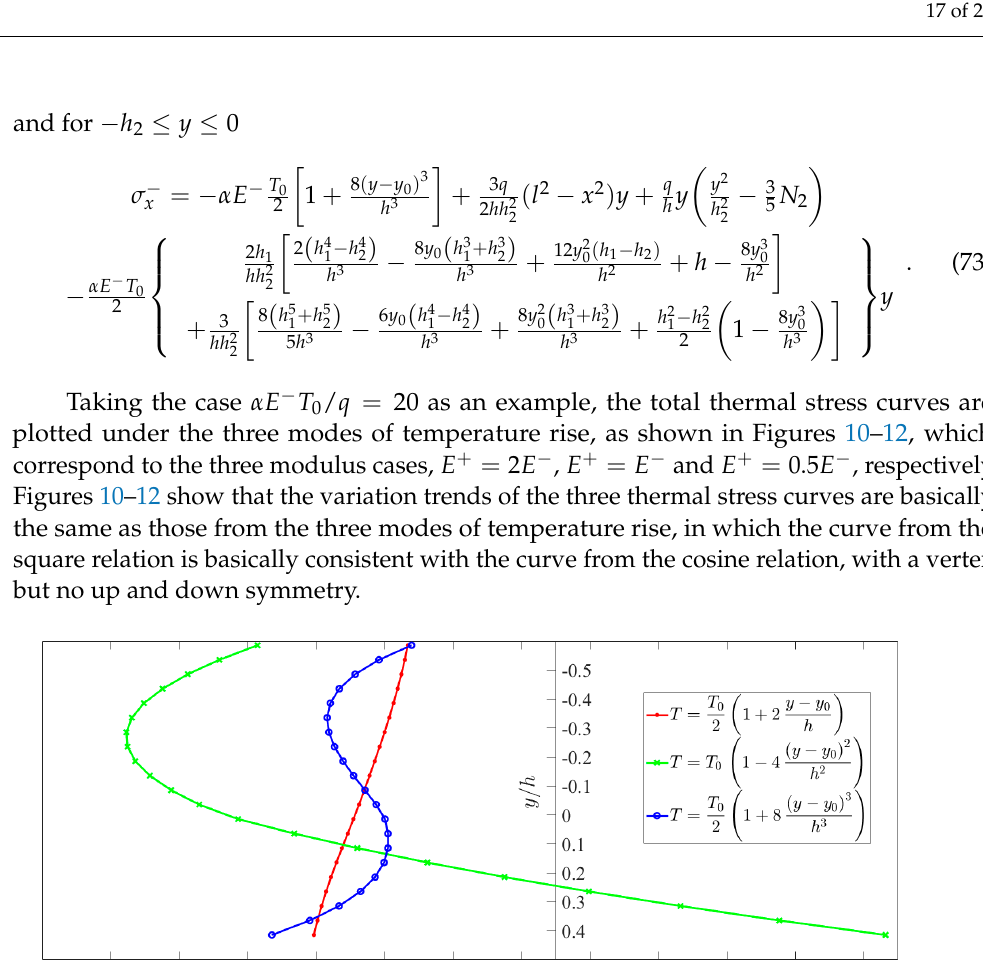
Figure 10. The total stress when 2 E E